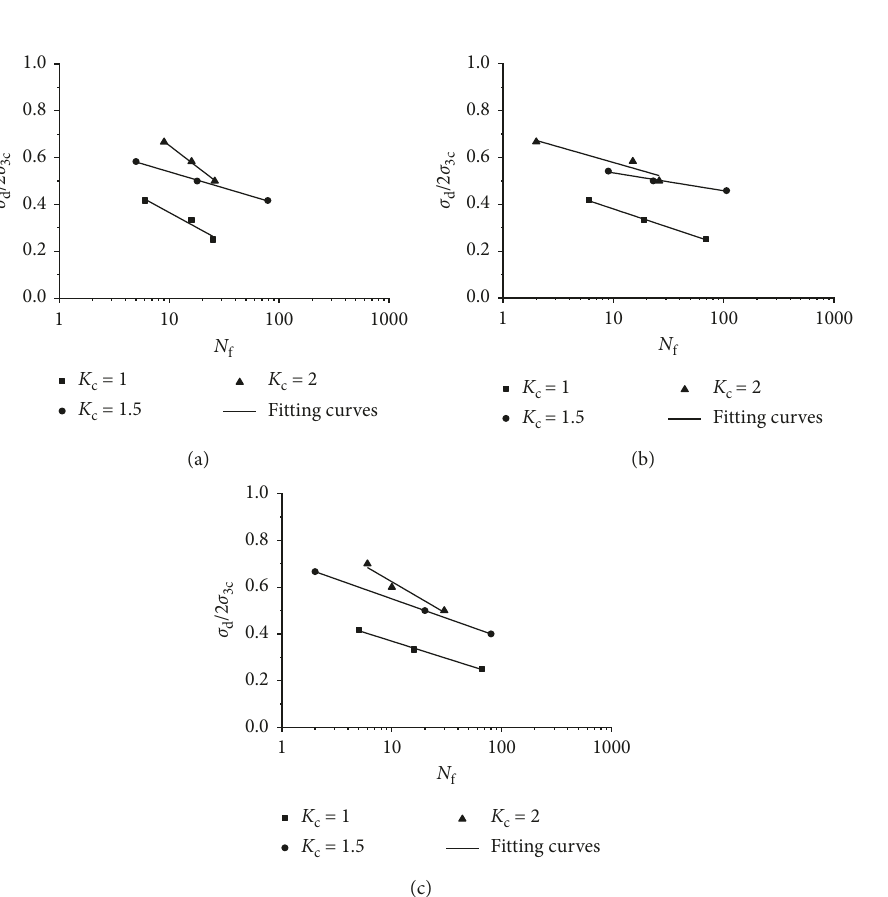
Figure 2: Relationship curves between cyclic stress ratio and failure cycles under different initial shear stresses at f � 1 Hz: (a) σ (b) σ 3c � 100kPa; (c) σ 3c � 150kPa.